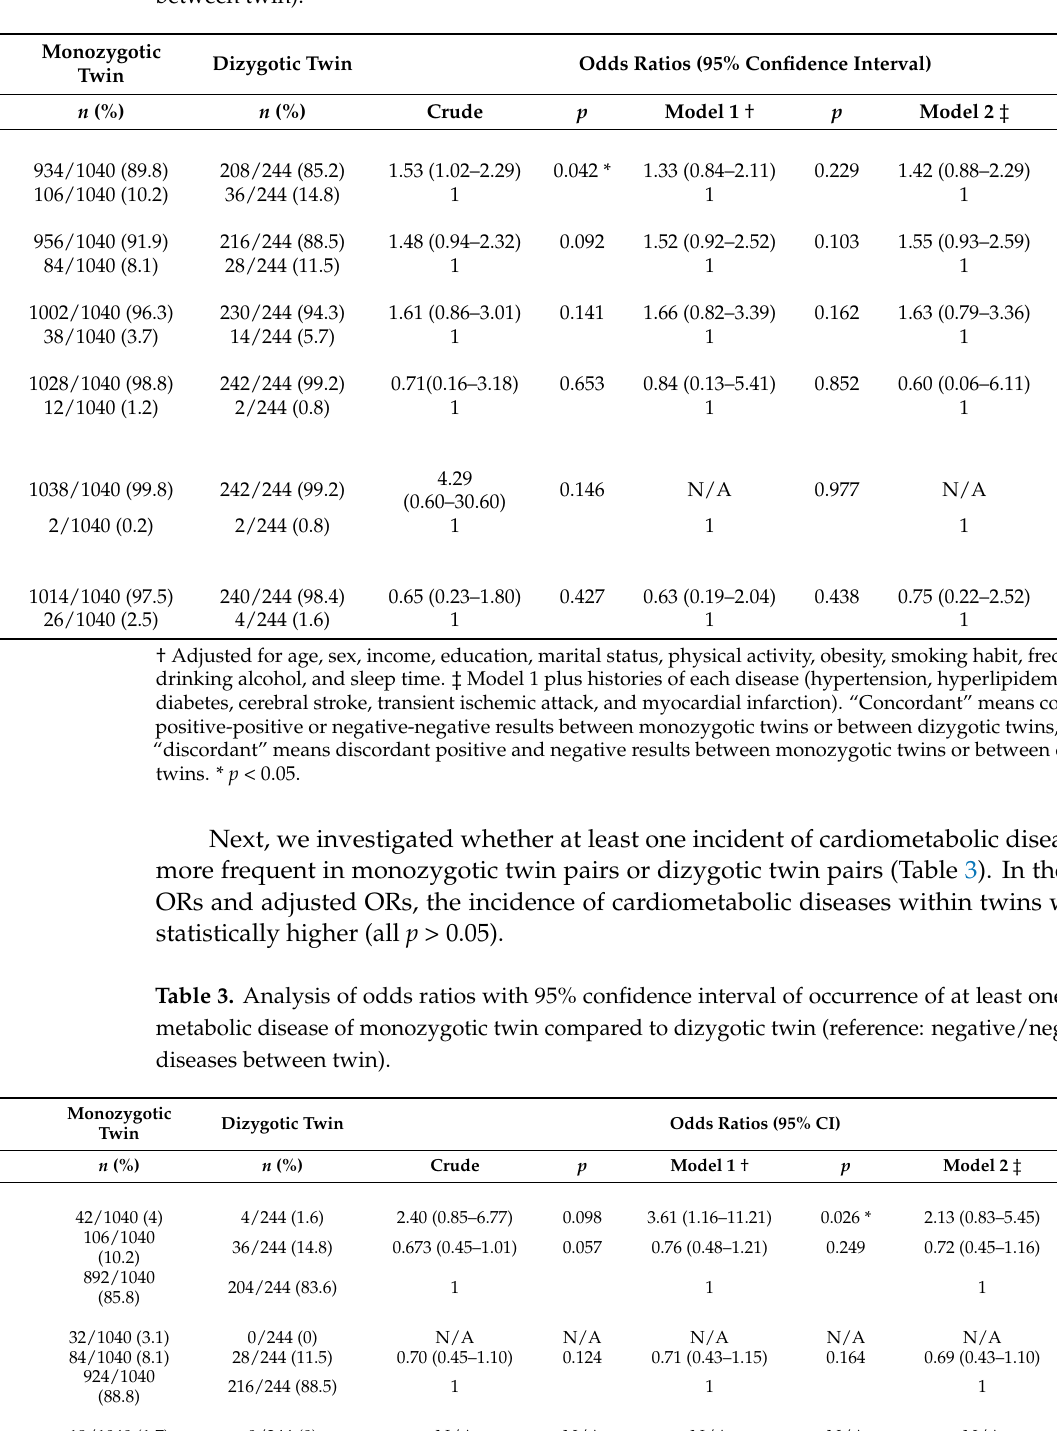
Table 2. Analysis of odds ratios with 95% confidence interval of coincidence of cardio-metabolic diseases of monozygotic twin compared to dizygotic twin (reference: positive/negative of diseases between twin).